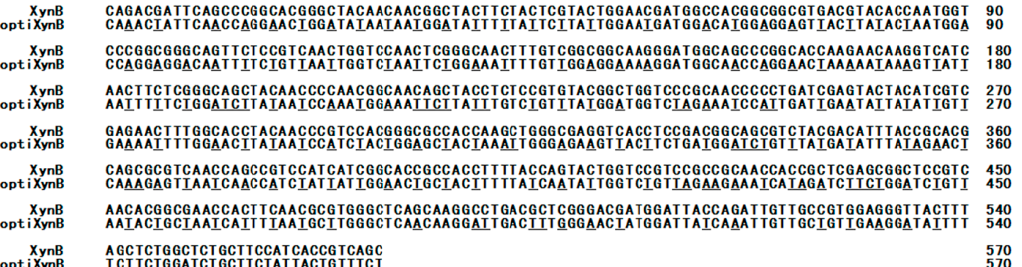
Figure 1. Comparison of T. reesei xylanase gene ( XynB ) and optimized xylanase gene ( optiXynB ). The underline letters are the changed codons.